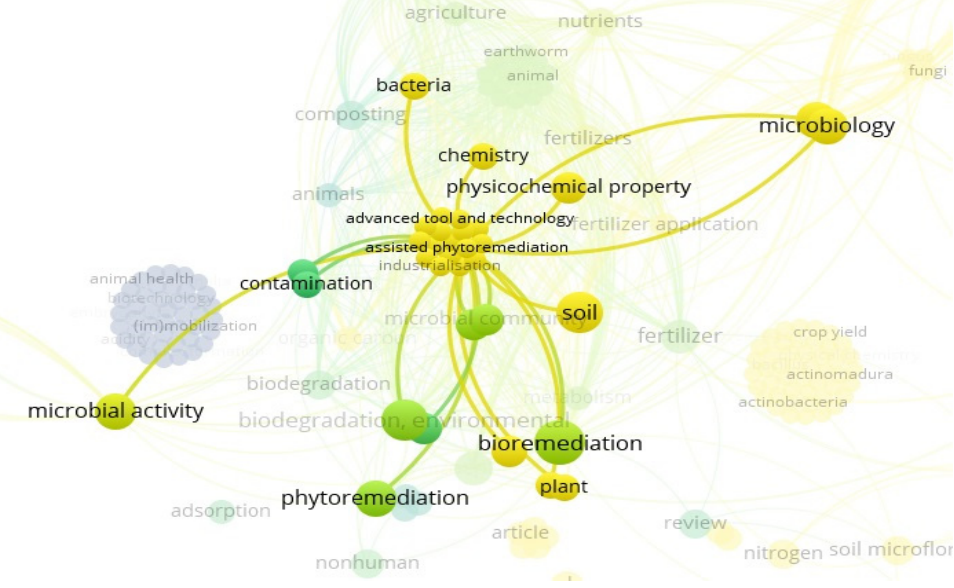
Figure 11. Analyzing Scopus results with the VOSviewer. The microplastics ( a ) and health risks ( b ) paradigms.